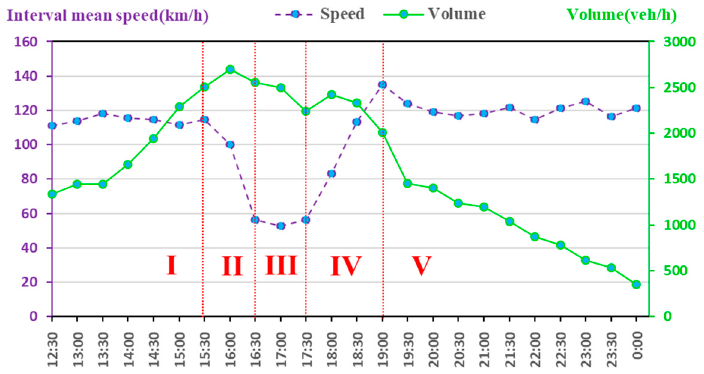
Figure 5. The dynamic variance of interval mean velocity and volume at different phase.